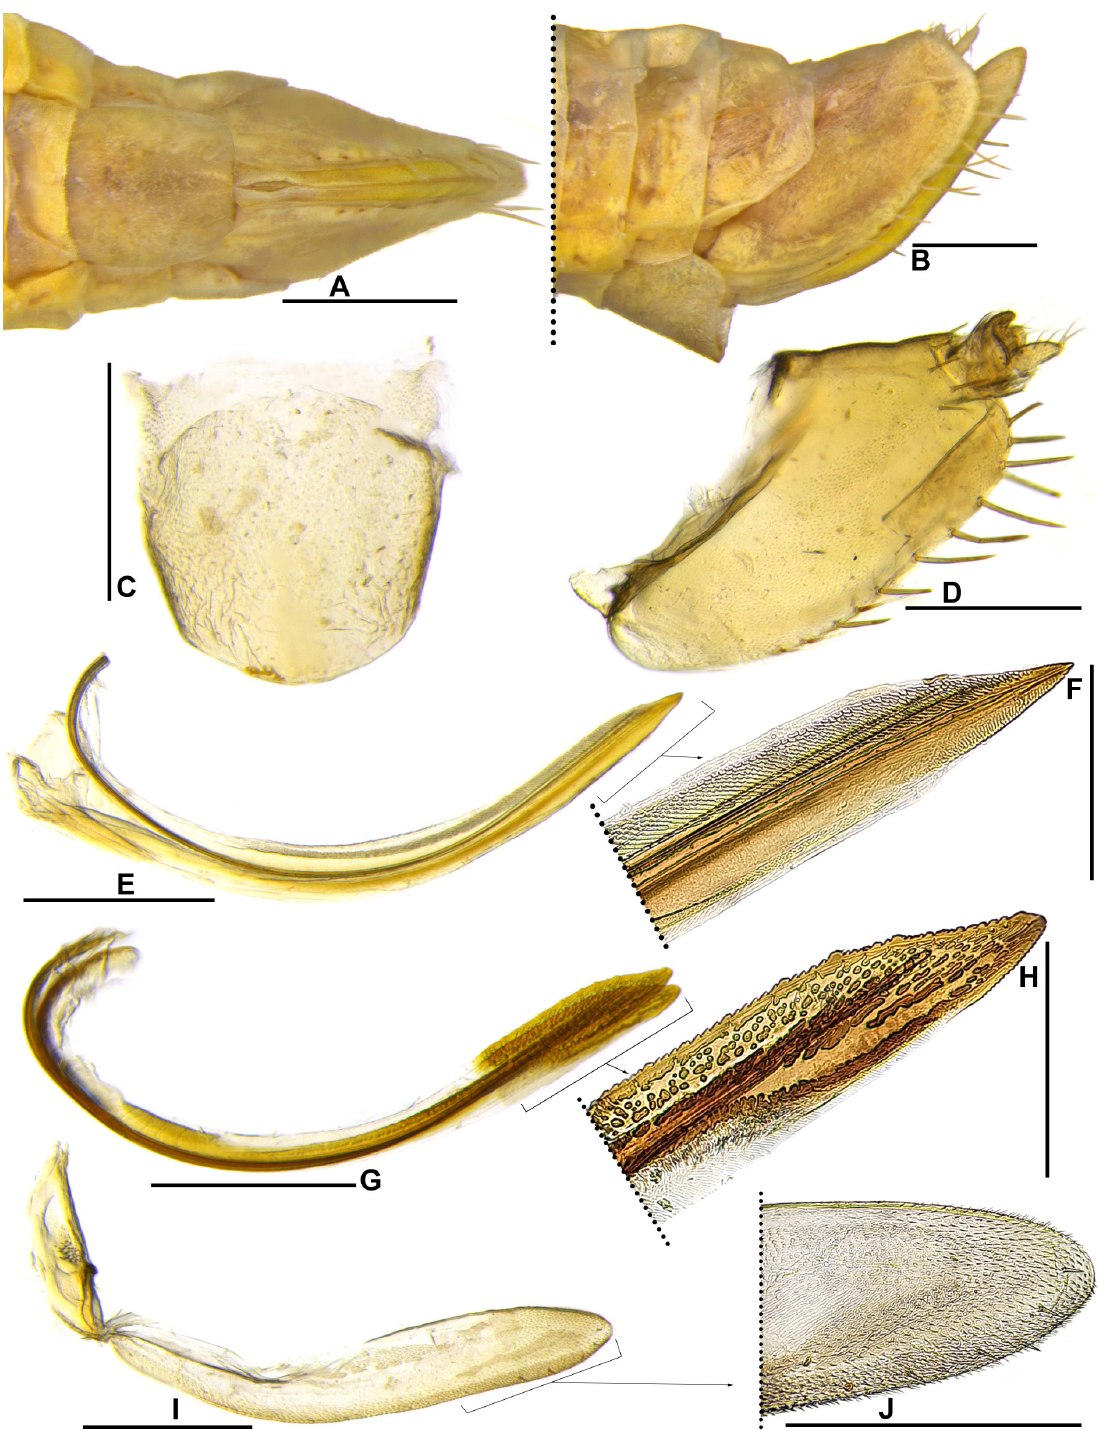
Fig. 9. Takiyaella mejdalanii gen. et sp. nov., ♀, paratype (DZRJ-AUCH #247). A . Posterior portion of abdomen, ventral view. B . Posterior portion of abdomen, lateral view. C . Sternite VII, ventral view. D . Pygofer and anal tube, lateral view. E . First valvula of ovipositor, lateral view. F . Apex of first valvula, lateral view. G . Second valvula of ovipositor, lateral view. H . Apex of second valvula, lateral view. I . Second valvifer and gonoplac, lateral view. J . Apex of gonoplac, lateral view. Scale bars: A–B = 1.0 mm; C–E, G, I = 0.5 mm; F, H, J = 0.3